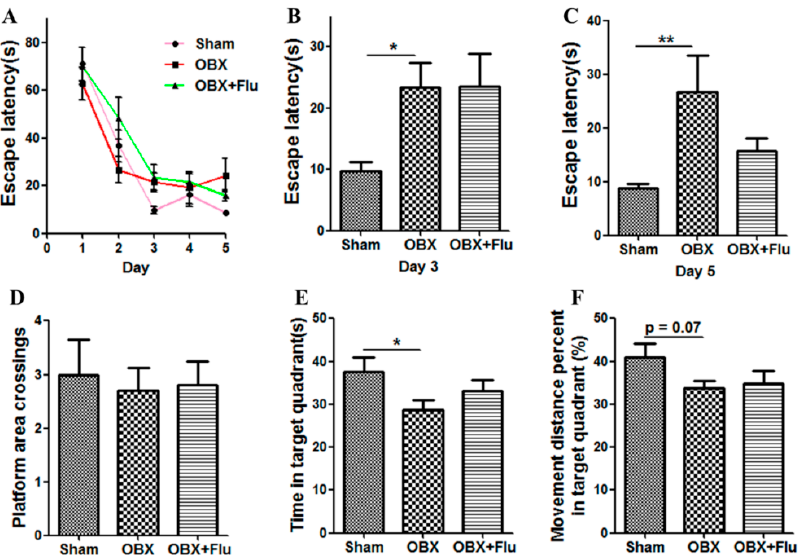
Figure 3. Effects of OBX and fluoxetine treatment on spatial memory of rats in the Morris water maze (MWM) test. ( A ) The latency to the hidden platform during the five-day navigation test. ( B , C ) The escape latency recorded on day 3 and day 5, respectively. On day 6, the platform was withdrawn. ( D ) Platform area crossings. ( E ) Time spent in the target quadrant. ( F ) Movement distance percent in the target quadrant. * p < 0.05, ** p < 0.01 compared to the sham group (means ± SEM, n = 8). Flu, fluoxetine. OBX, olfactory bulbectomy.